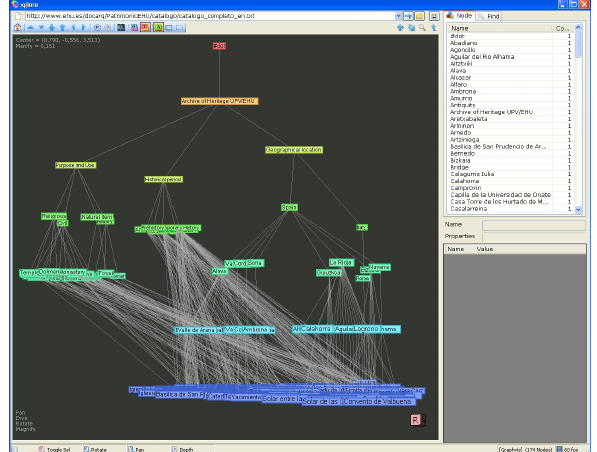
Figure 1. Interactive 3D-graph, the leaves at the bottom are linked with items stored in the repository (Rodriguez & Valle, 2013)